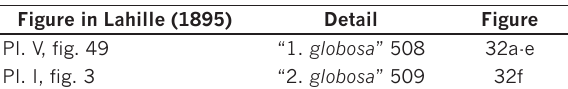
Table 11. Voluta colocynthis globosa , specimens figured by La - hille (1895) with the detail of the inscriptions on their shells and figures